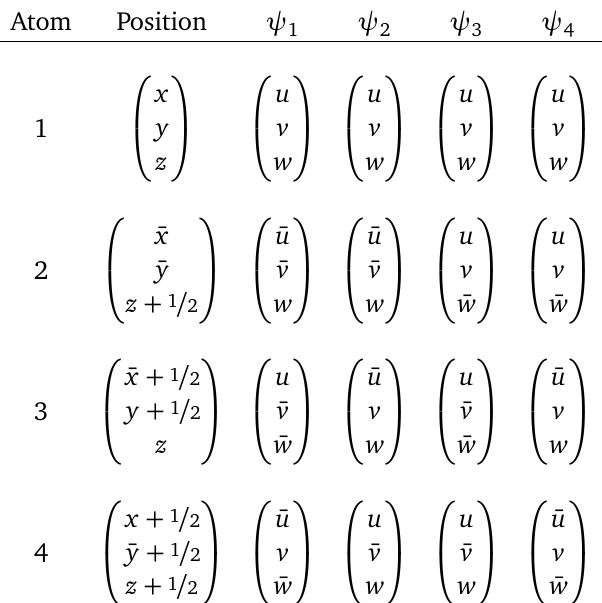
Table 2: Basis vectors ψ of the irreducible representation Γ n of CaBaFe O for space group Pbn2 and propagation vector q = (0 0 0). 4 7 1